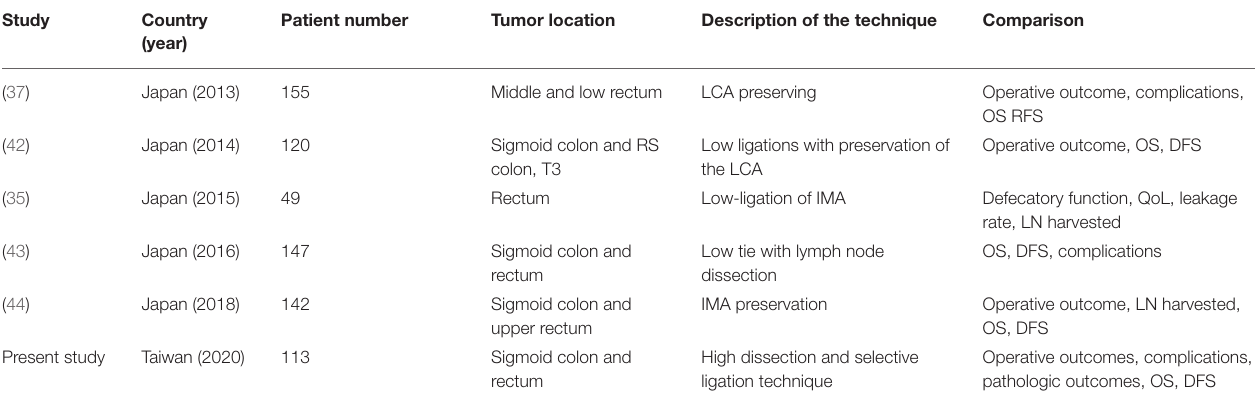
TABLE 4 | Studies regarding the high dissection and selective ligation technique published since 2013.